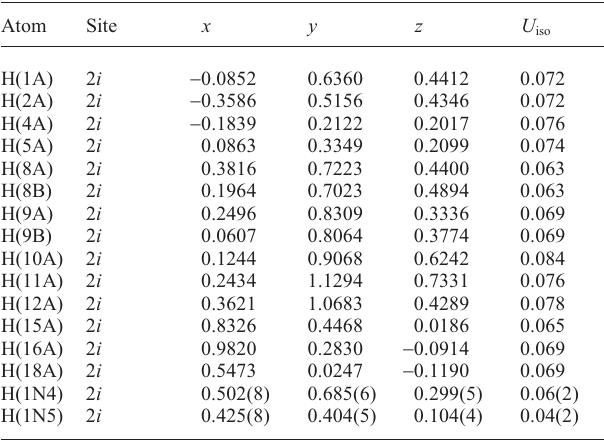
Table 2. Atomic coordinates and displacement parameters (in Å 2 )